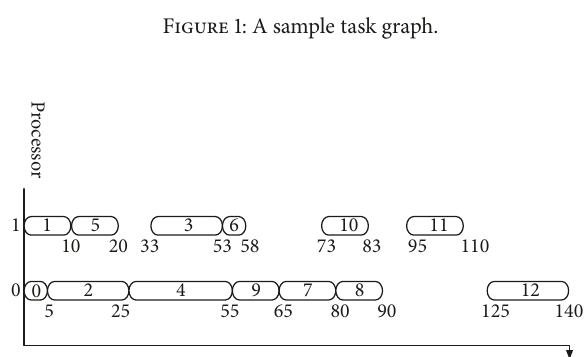
Figure 1: A sample task graph.